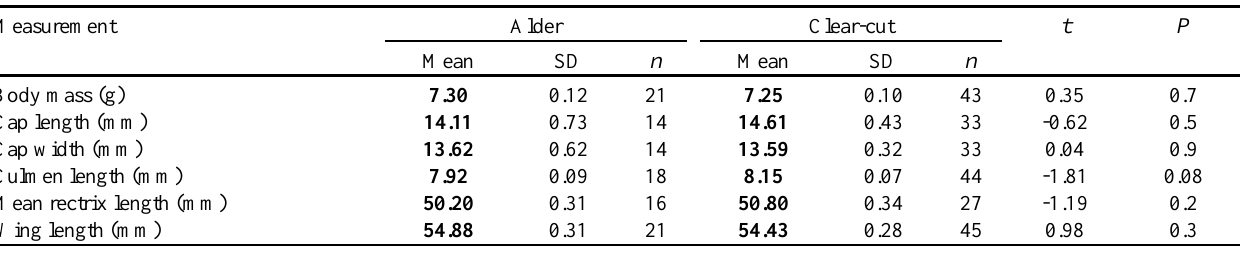
Table 3 . Morphology of male Wilson’s Warblers ( Cardellina pusilla ) in alder ( Alnus spp.) and clear-cut habitats at Forêt Montmorency, Québec, 2003-2004. Outer rectrix length is the mean of the two outer rectrices. Data from 2003 only. Measurement Alder